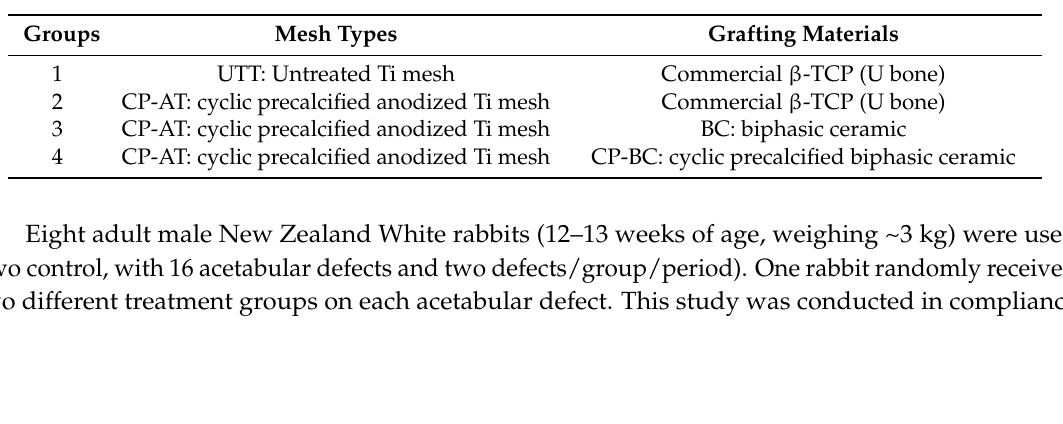
Table 1. Groups for in vivo